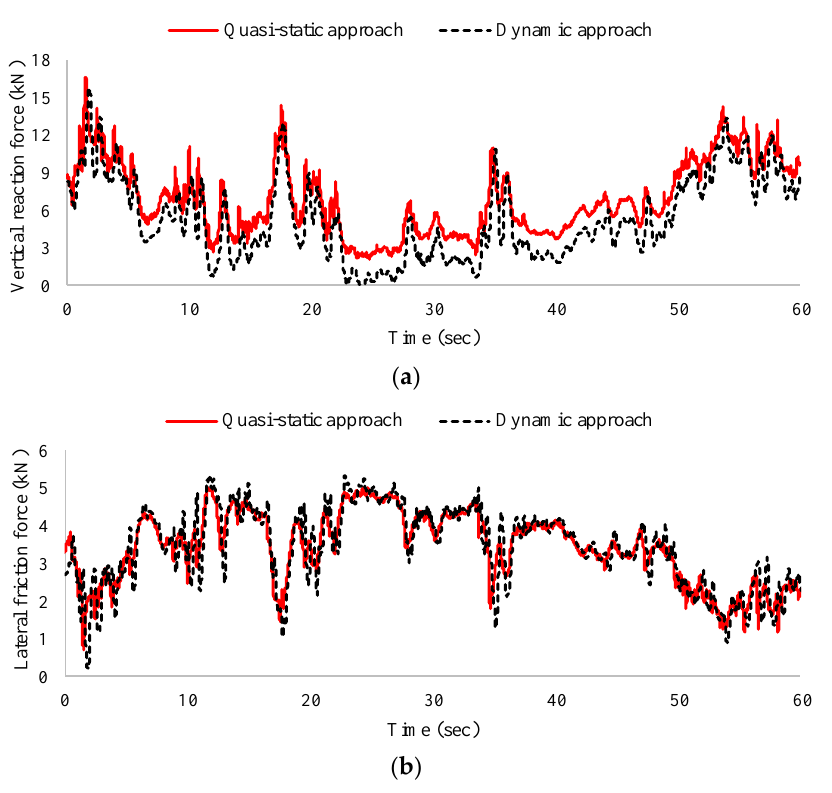
Figure 13. Time histories of reaction forces of the trailer: ( a ) vertical and ( b ) lateral force.